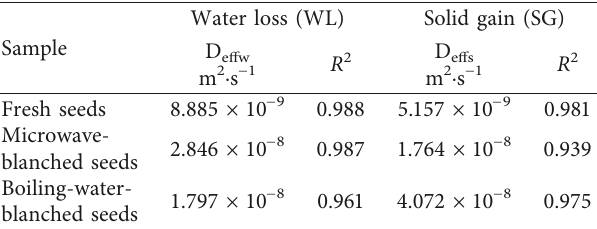
50 ° Bx, T 40 ° C, N 440rpm, and (cid:31) (cid:31) (cid:31) 1: (cid:31)